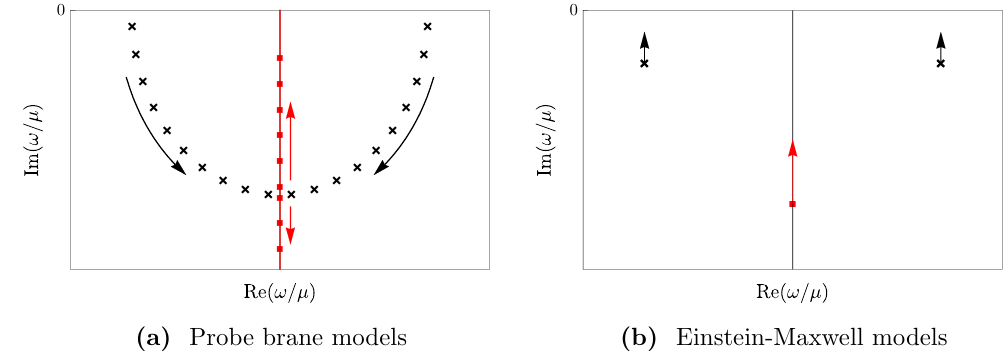
Figure 2. Schematic depictions of the movement of poles in the complex !=(cid:22) plane in sound- channel J (cid:22) and/or T (cid:22)(cid:23) correlators in HZS models. The arrows indicate the motion of poles as T=(cid:22) increases. The black crosses represent sound poles, while the (upper) red square represents the charge di(cid:11)usion pole. (a) In spacetime-(cid:12)lling probe brane models, the two HZS poles move down, approximately tracing semi-circles, collide on the imaginary axis, and split into two purely imaginary poles, one moving up and one moving down, where the former is the charge di(cid:11)usion pole. (b) In Einstein-Maxwell models, all three poles simply move up towards the real axis, with the sound poles’ real parts